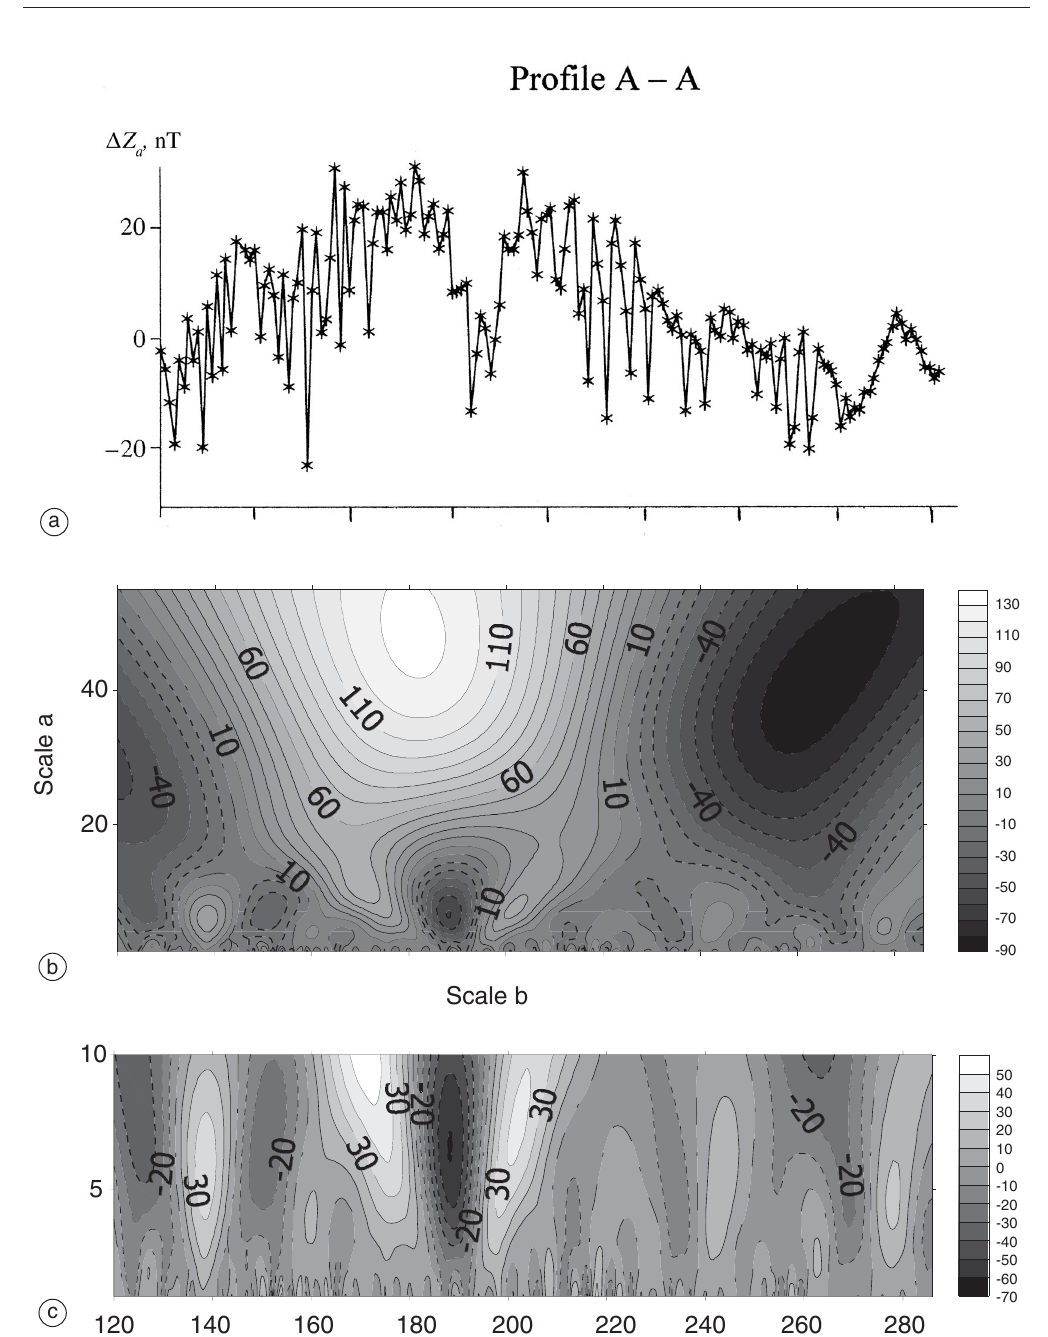
Fig. 3a-c. Profile of the anomaly magnetic field for the Pacific Ocean area along ϕ= 30°N (a) and its wavelet transform for different values of the characteristic scale a